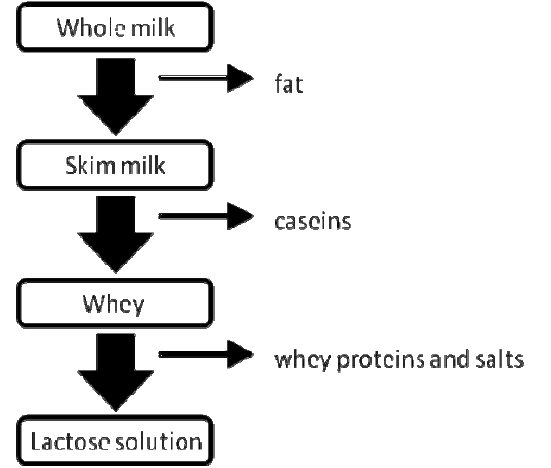
Figure 2. Simplified relation of dairy streams tested for DCMD to estimate influence of different milk components on overall process